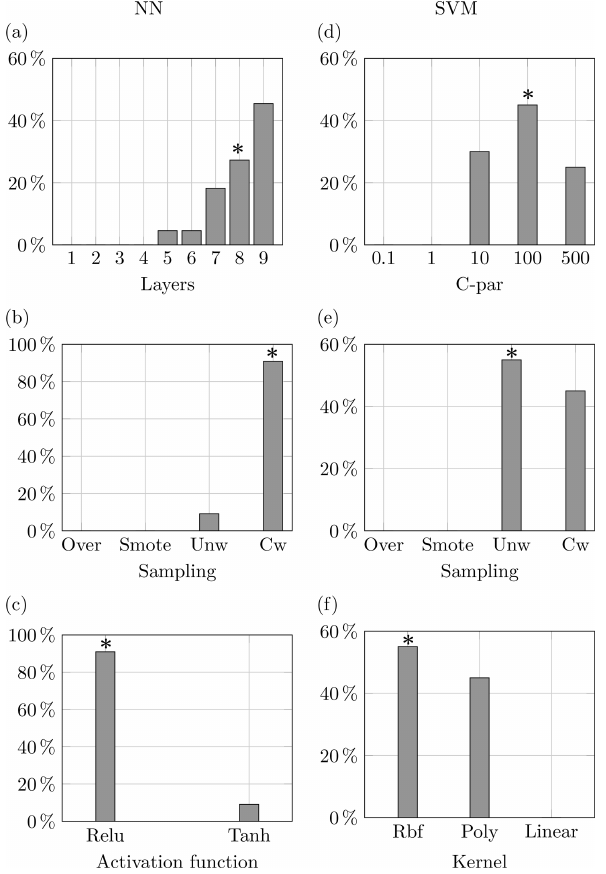
Figure 15. Properties of top 1% model configurations for the drought case. The stars denote the characteristics of the best- performing configurations according to the highest area under the precision-sensitivity